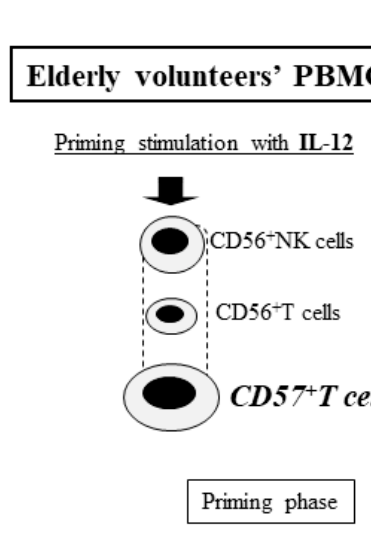
Figure 4. The in vitro Shwartzman reaction-like response in human peripheral blood mononuclear cells (PBMCs). ( A ) IL-12 stimulation and subsequent LPS stimulation 24 h later induced enhanced TNF production in cultured human PBMCs, suggesting an in vitro Shwartzman reaction-like response. ( B ) In PBMCs from young volunteers, IL-12 priming activates CD56 + NK, CD56 + T, and CD57 + T cells to produce IFN- γ , which primes macrophages. Subsequent LPS stimulation strongly activates the primed macrophages to produce large amounts of TNF, suggesting an in vitro Shwartzman reaction-like response. ( C ) In PBMCs from elderly volunteers, IL-12-priming potently activates CD57 + T cells, which show an age-dependent increase, and augments IFN- γ production, which enhances macrophage priming. The subsequent LPS stimulation further augments the TNF production from potently primed macrophages, suggesting an enhancement of the in vitro Shwartzman reaction-like response. Figures are revised from